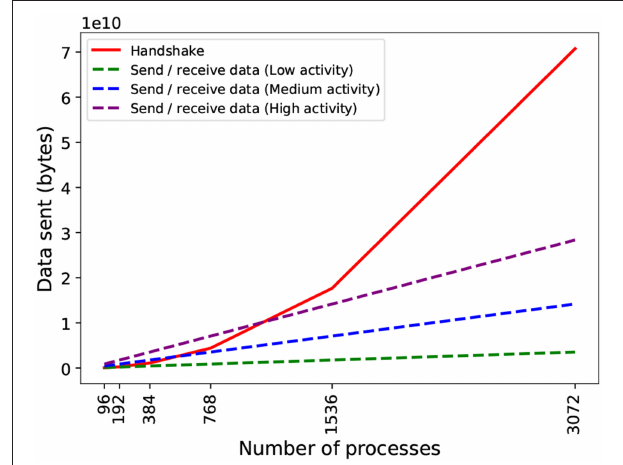
FIGURE 5 | Theoretical data volume exchanged in the two phases of communication by PEX on an artificial network with constant spiking activity (20 spikes/s for low activity, 80 spikes/s for medium activity, and 160 spikes/s for high activity). During spiking data exchange, processes send data to each other in two phases: handshake (coordinating intention to send information) in solid red line; and send-receive spiking data, in dashed lines. The send-receive exchange volume is dependent on the activity density (spiking average) per process. The communication profile of the simulation and the number of processes used determines which phase is